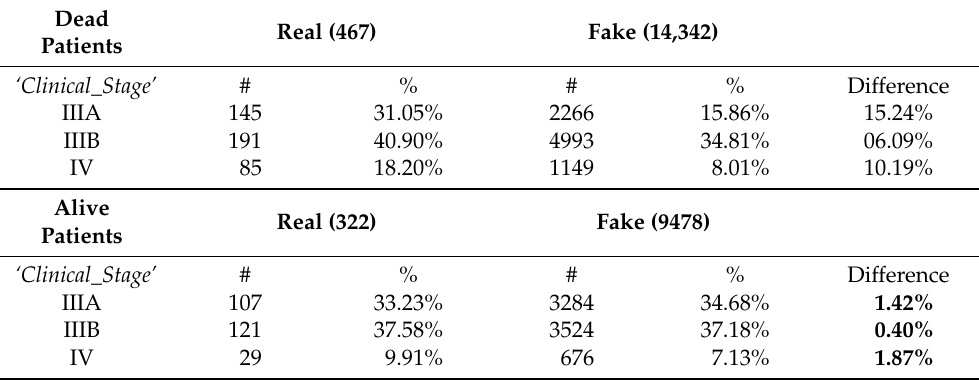
Table 7. Results of the ‘Recorded_Clinical_Stage’ feature related with ‘Recorded_Status’ features.